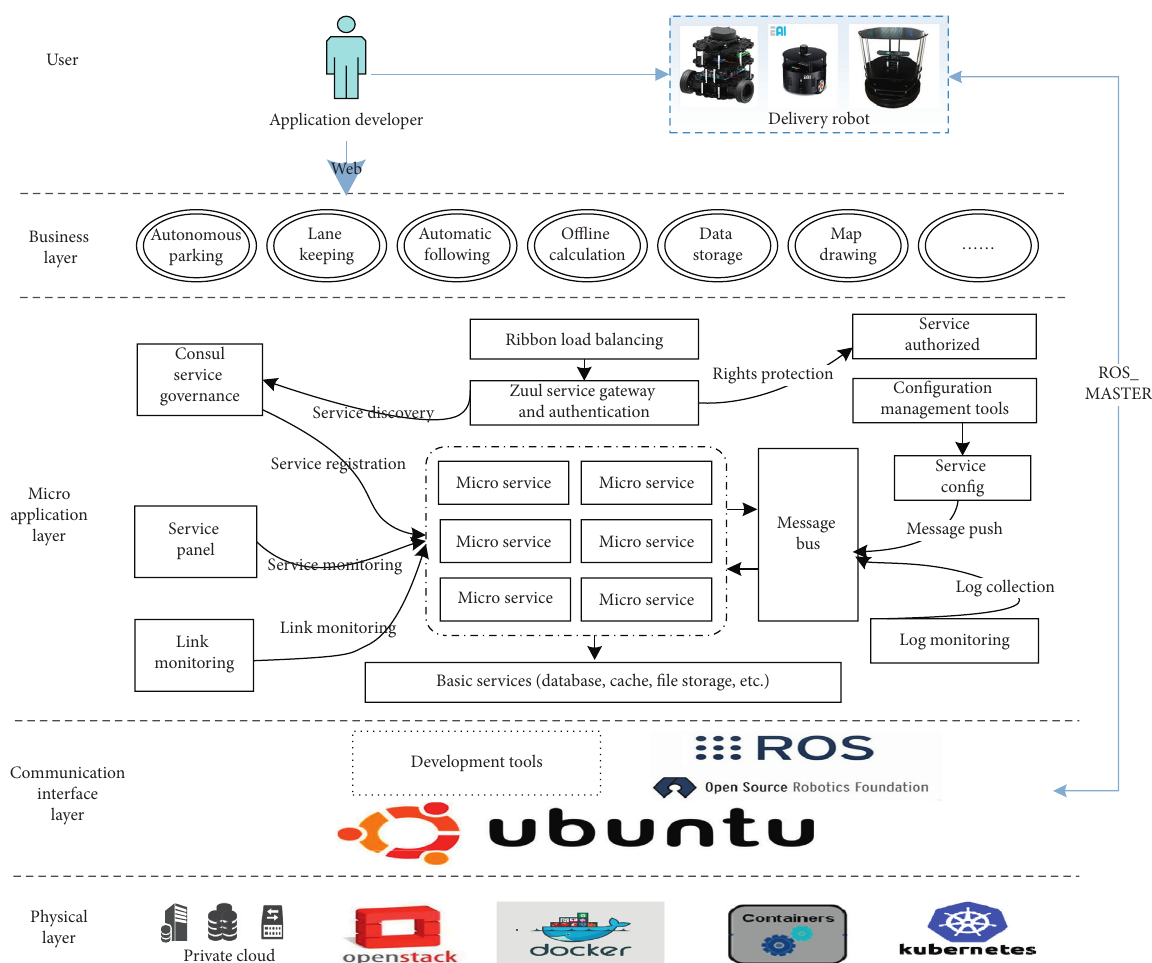
Figure 1: Delivery robot cloud platform based on